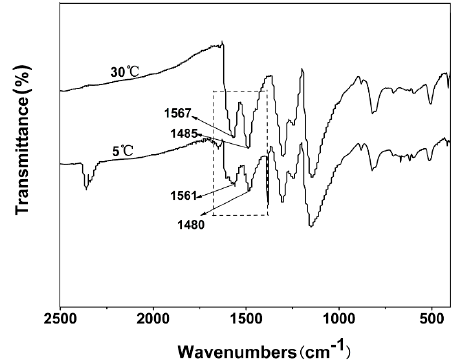
Figure 8. Effects of polymerization temperature on the electrical conductivity of PANI/ASPB nanocomposite.